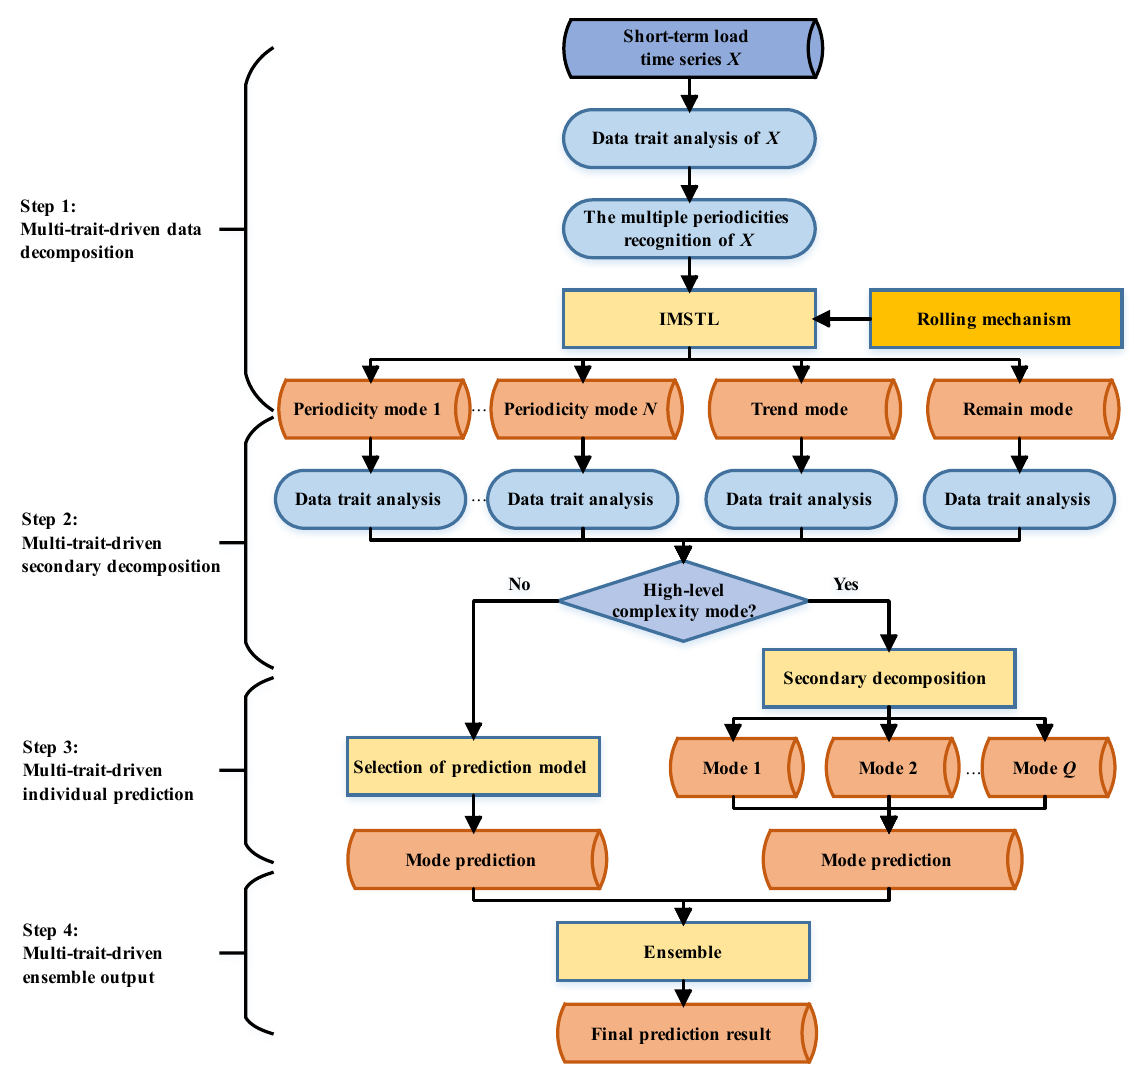
Figure 1. The framework of the proposed model.